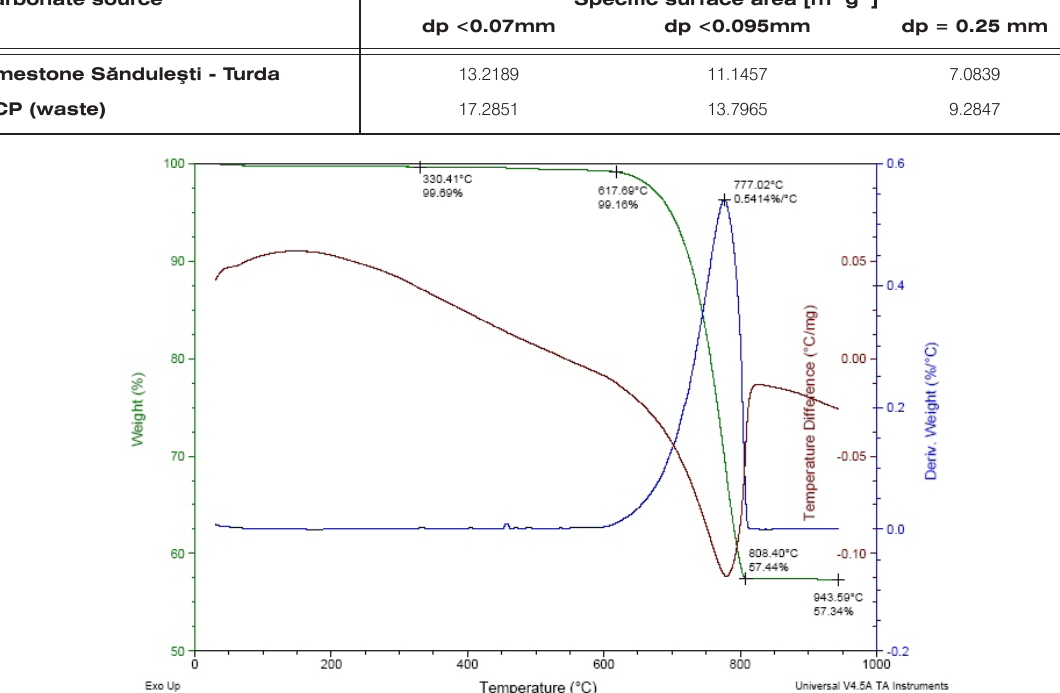
Figure 4. DSC-TGA for limestone.